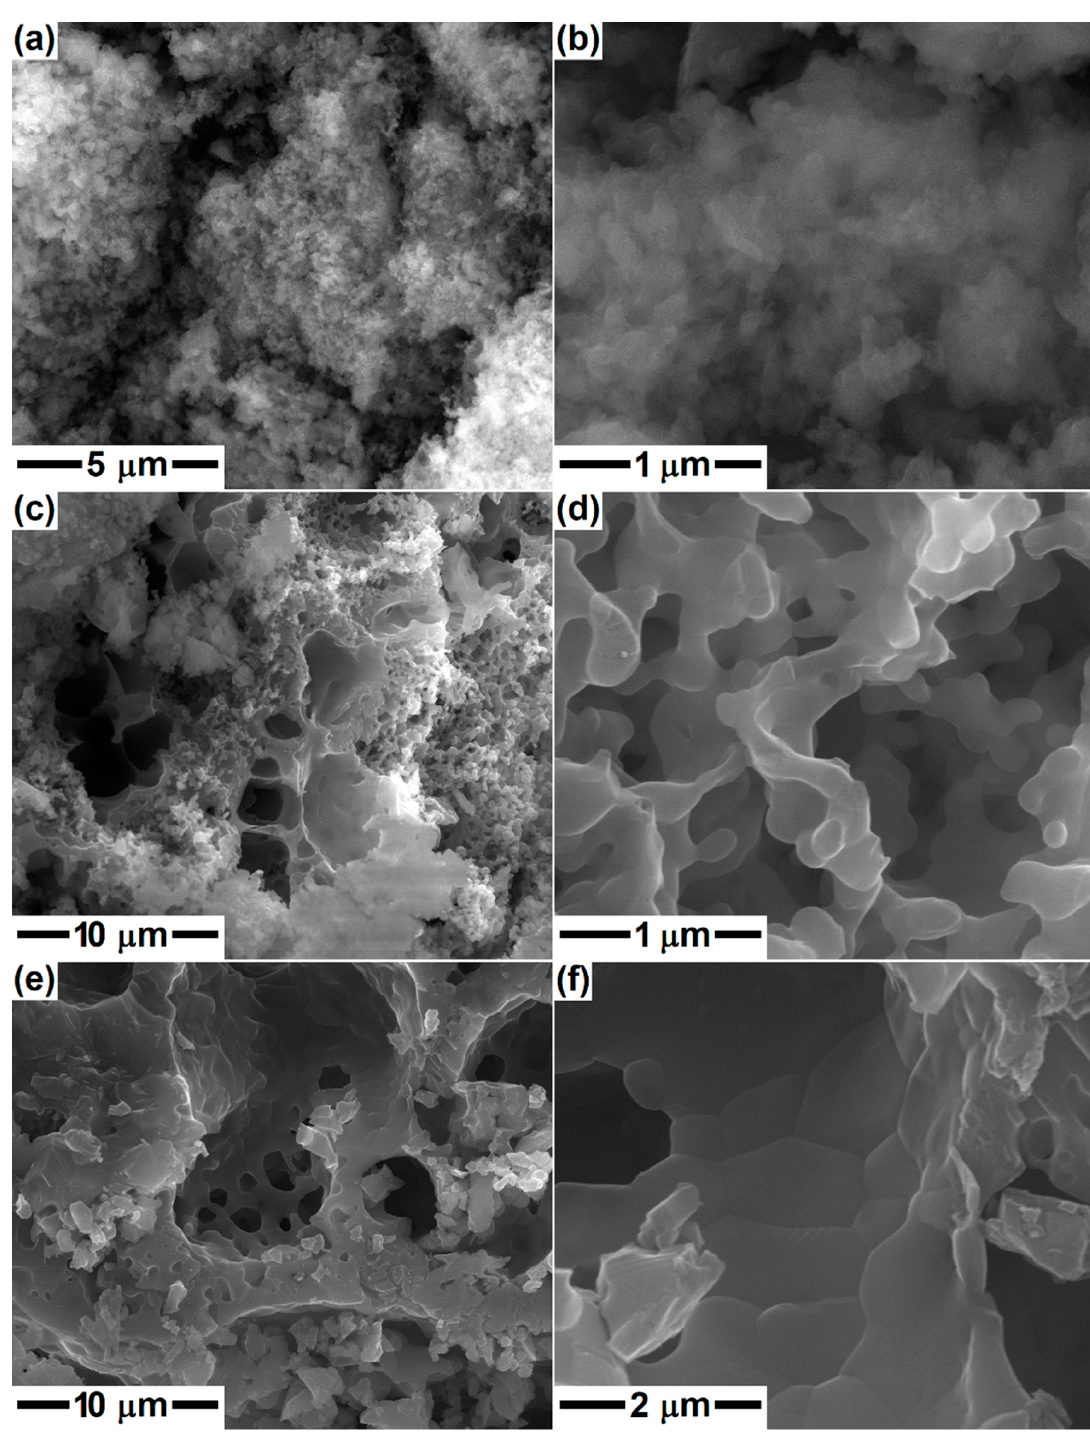
Figure 5. SEM images of the ceramics corresponding to merwinite composition, thermally treated at: ( a , b ) 600 °C; ( c , d ) 1000 °C; and ( e , f ) 1300 °C.